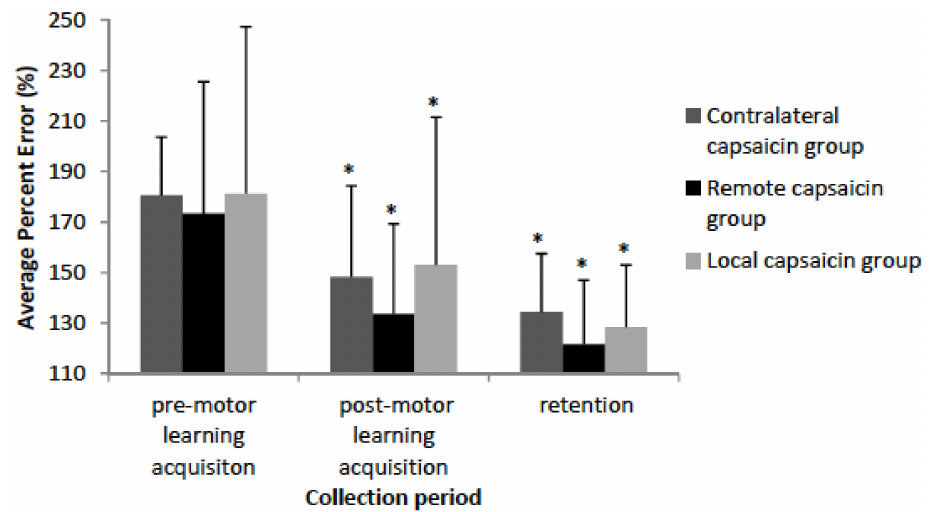
Figure 5. Bar graph depicting the percent error by group. The remote, local, and contralateral and capsaicin groups improved in accuracy following motor learning acquisition ( p < 0.001) and at retention ( p < 0.001) as indicated by asterisks. Error bars represent the standard deviation.